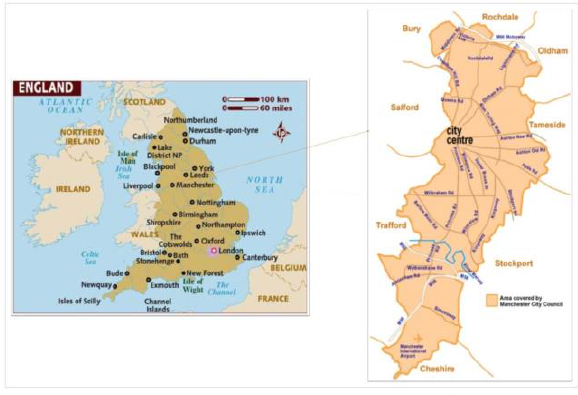
Figure 1. Study area – Manchester Metropolitan UK